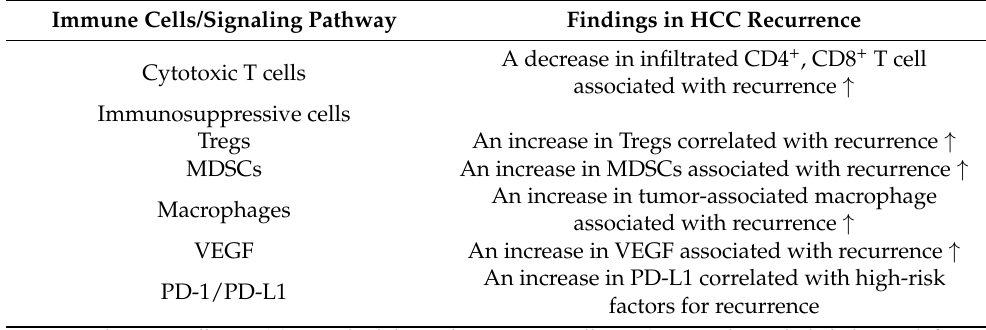
Table 1. Immunological factors for recurrence of hepatocellular carcinoma following curative treat- ments. Immune Cells/Signaling Pathway Findings in HCC Recurrence Cytotoxic T cells Immunosuppressive